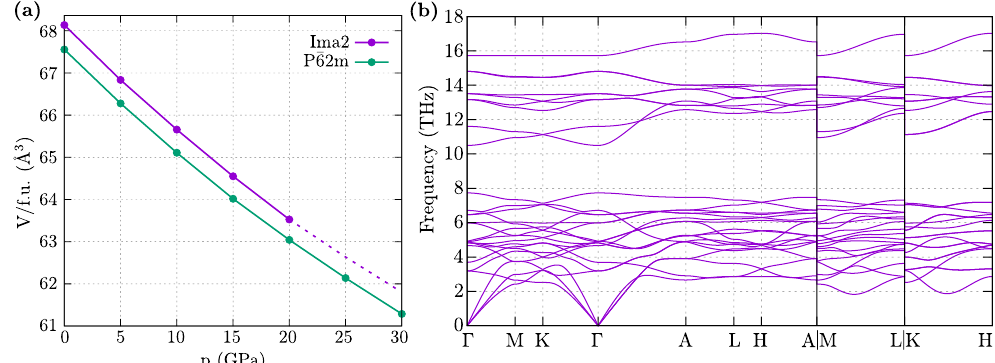
Figure 5. Influence of external hydrostatic pressure on NbReSi. ( a ) Pressure dependence of the unit cell volume (per formula unit) for system with P¯62m and Ima2 symmetries (as labeled). ( b ) Phonon dispersion curves for system with P¯62m under pressure 30